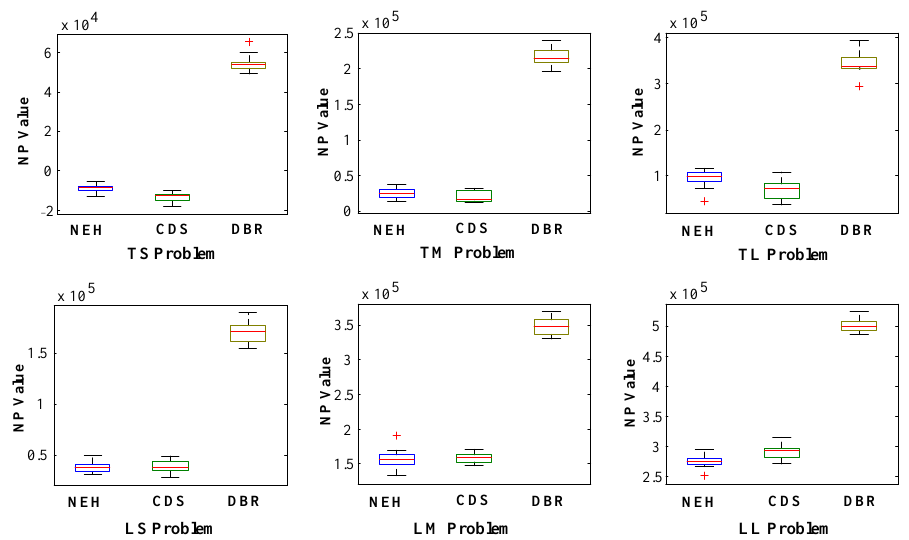
Figure 6. NP results for each category of problem in different scenarios.